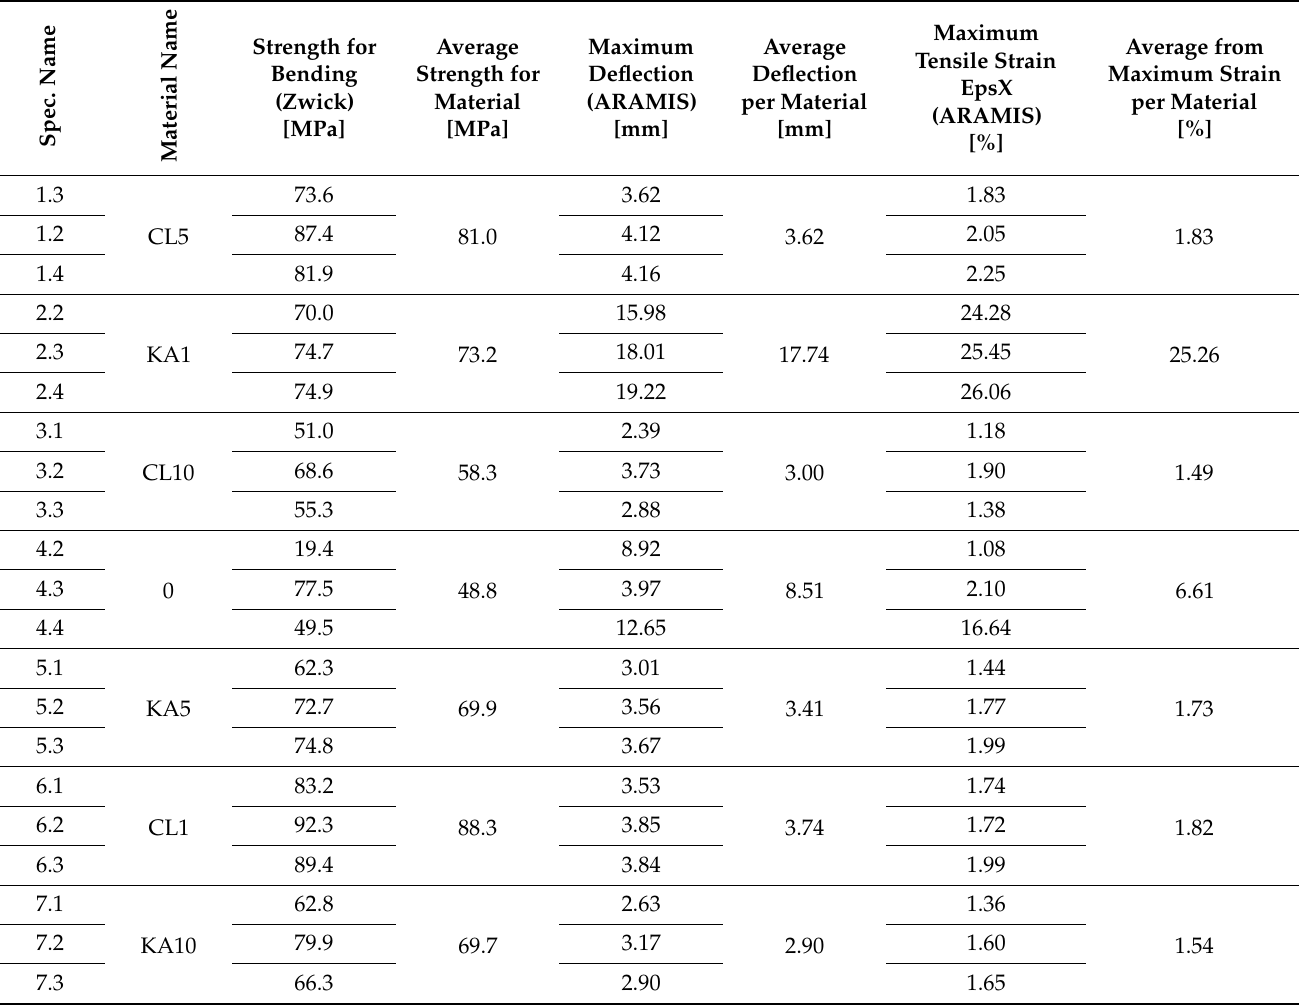
Table 4. Bending and tensile strain